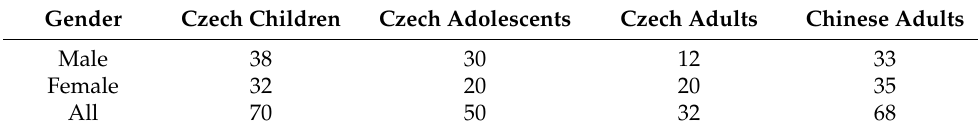
Table 1. Subjects involved in the study. The number of participants in a particular group.